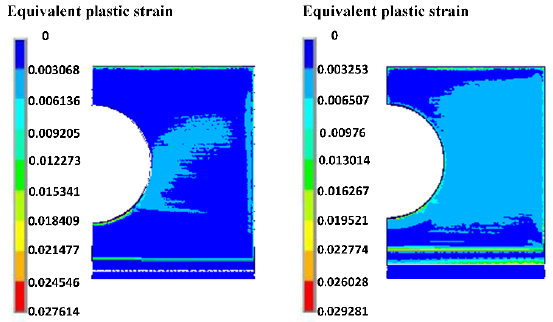
Figure 7. The plastic strain of the fracture surface: ( a ) C70S6; ( b ) 36MnVS4.